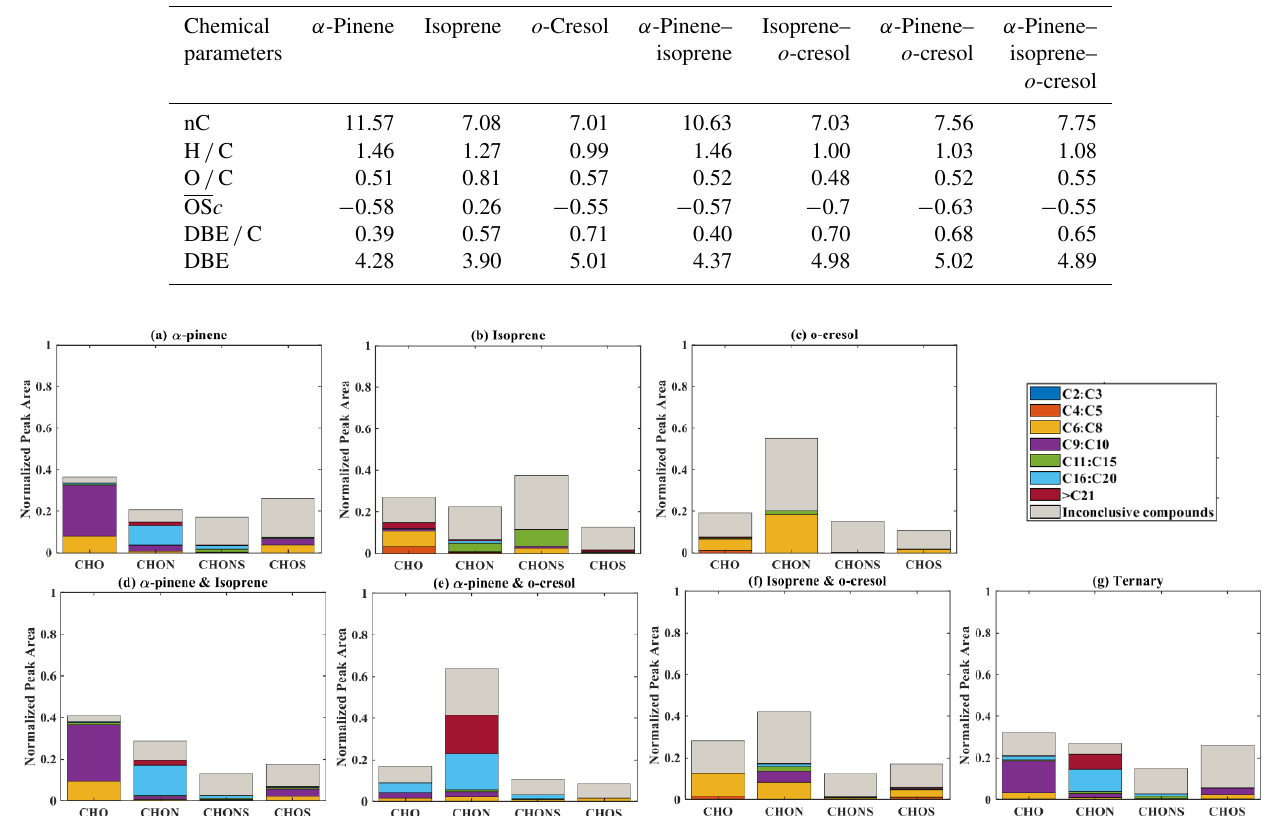
Figure 5. The normalized signal intensity distribution of different compound categories (CHO, CHON, CHOS, and CHONS) for various single and mixed precursor systems in positive ionization mode by LC-Orbitrap MS. The grey bar (inconclusive compounds) is the signal attributed to compounds that were not universally found in all repeat